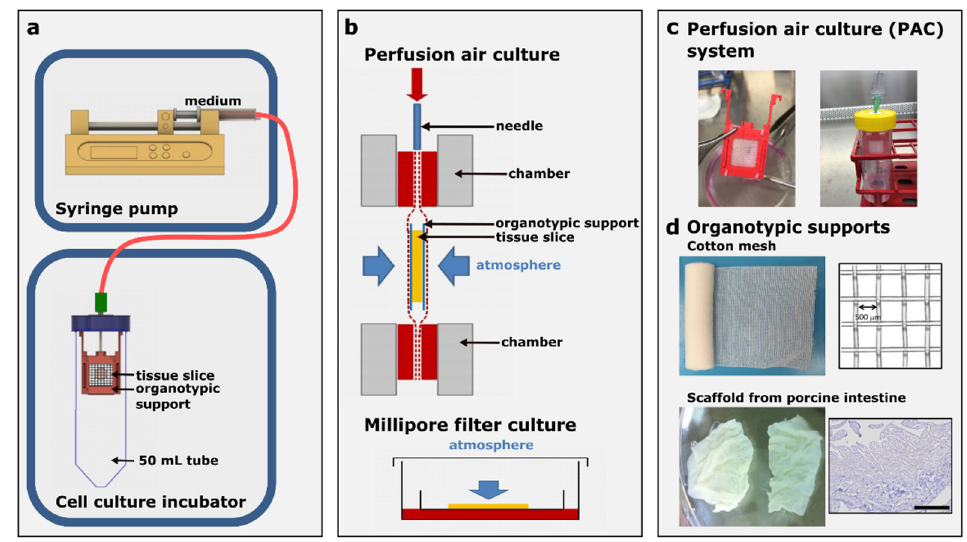
Figure 1. Details of the perfusion air culture (PAC) system for tumor slice culture. ( a ) The precision- cut tumor slices (250 µm to 280 µm thickness) are cultured in between two organotypic supports and fixed in a special chamber allowing continuous perfusion with the medium and drugs (perfusion rate: 2 mL per day). The chamber is settled vertically inside of a 50 mL tube with air exchange capacity and connected to a syringe pump via a silicone tube. The system is placed inside a cell culture incubator. ( b ) Cross-section of the setup of the PAC system and the commonly used Millipore filter (Millicell Cell Culture inserts) culture system. ( c ) An actual sample of the chamber packed with the tumor slice and the chamber inside the PAC system for cultivation. ( d ) Two different types of organotypic supports were used in the PAC system for different cultivation purposes: cotton meshes with a 500 µm opening size and scaffolds from a porcine intestine as shown by the H&E-stained structure. The scale bar represents 100 µm.